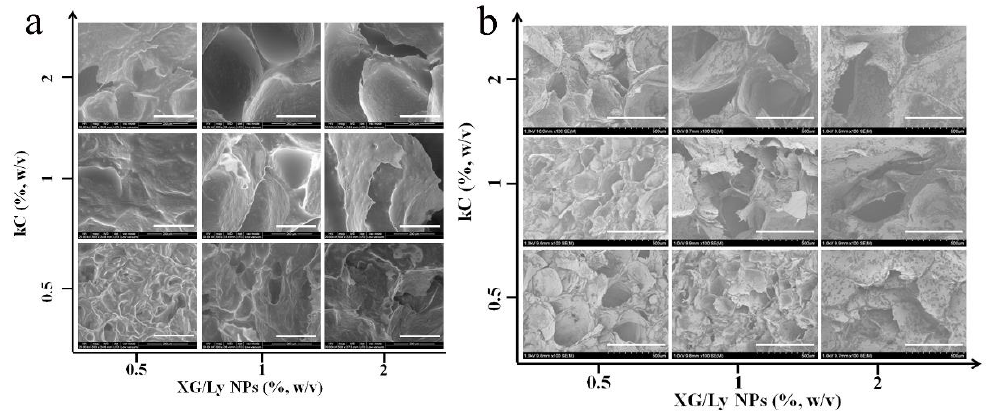
Figure 3. SEM images of Pickering emulsion gels with different concentrations of kC and XG/Ly NPs. ( a ), oil droplets reserve, scale bar 200 μm; ( b ), oil droplets remove, scale bar 500 μm.